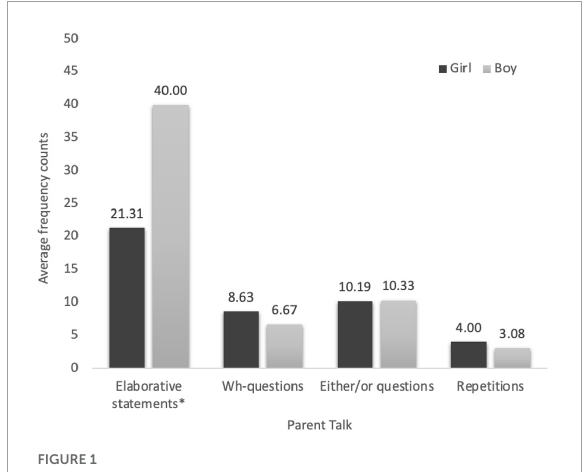
FIGURE1 Average frequency of parent talk by child